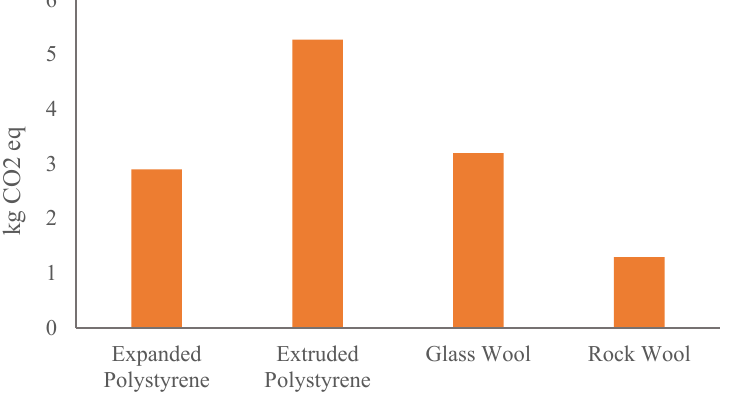
Figure 11. Global warming (Kg CO 2 eq emissions).